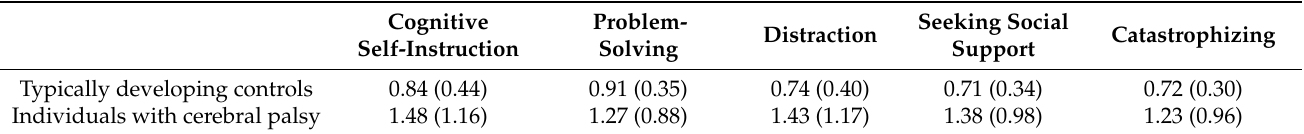
Table 2. Means and standard deviation of the frequency of pain-coping strategies in individuals with cerebral palsy and controls with typical